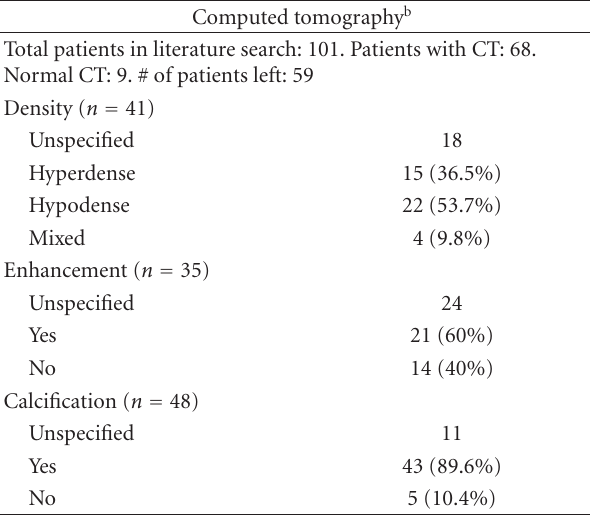
Table 2: Meningioangiomatosis appearance on computed tomog- raphy. Summary of the CT head imaging findings of meningoan- giomatosis cases reported in the